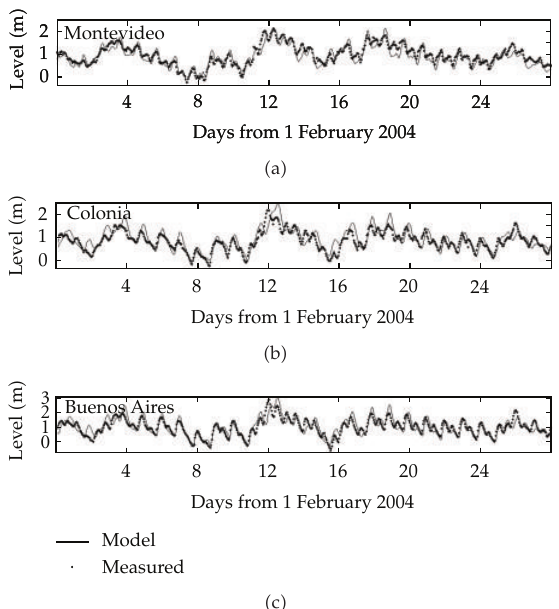
Figure 9: Comparison of water level measured and obtained with the model in three stations of the Rio de la Plata during February